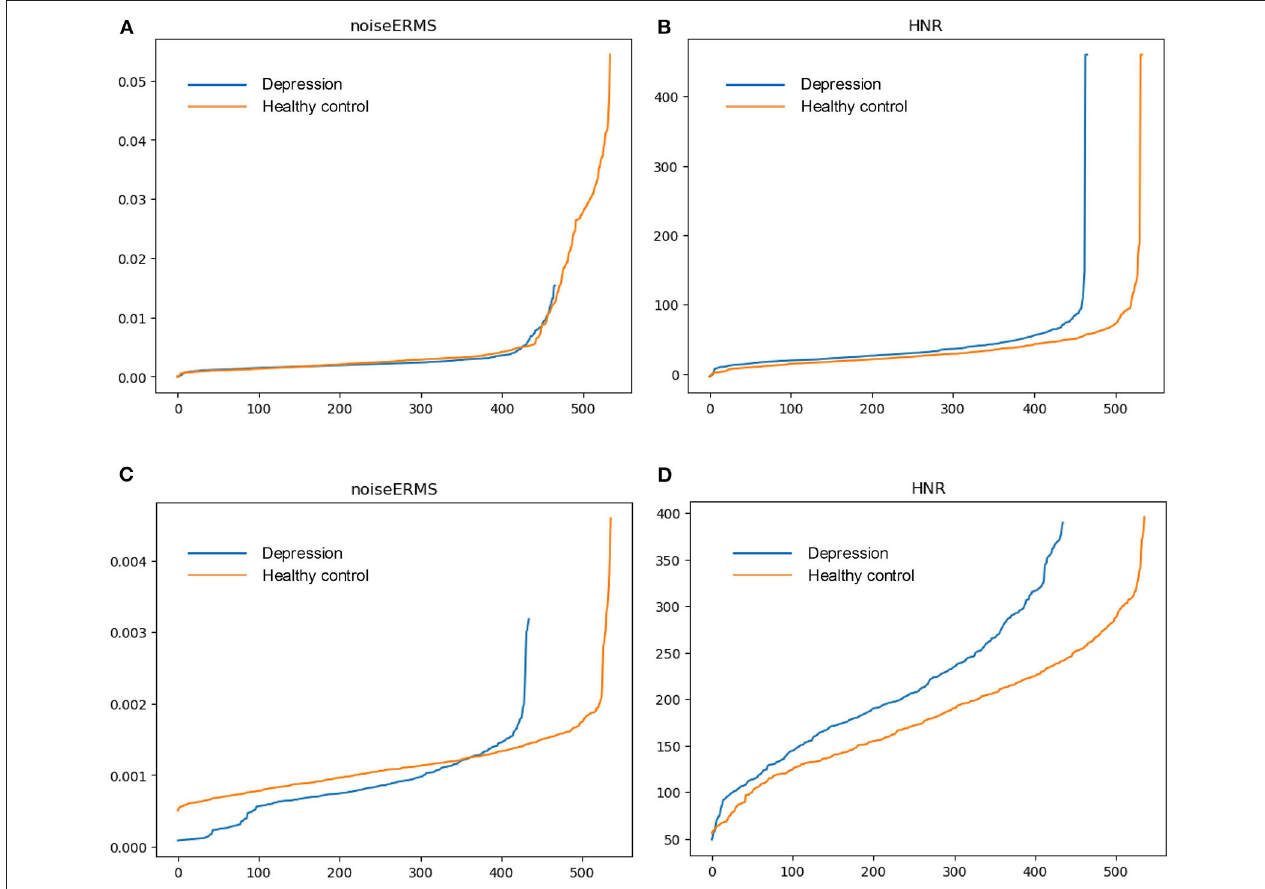
FIGURE 2 | Feature (noiseERMS and HNR) comparison. (A,B) are feature mean values on the DAIC-WOZ corpus, while (C,D) are feature mean values on the MODMA